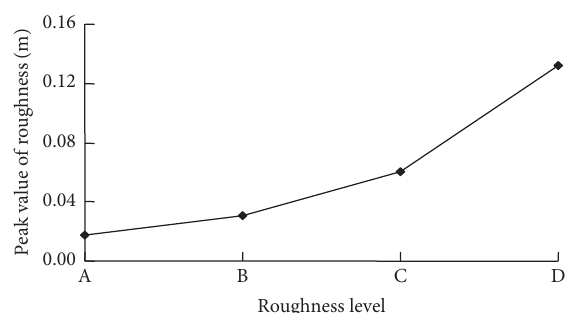
Figure 6: The variation curve of peak values of road roughness for various